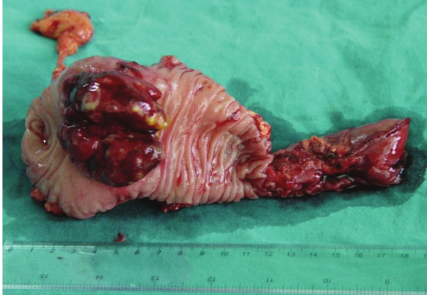
Figure 2: Gross appearance of the tumor.